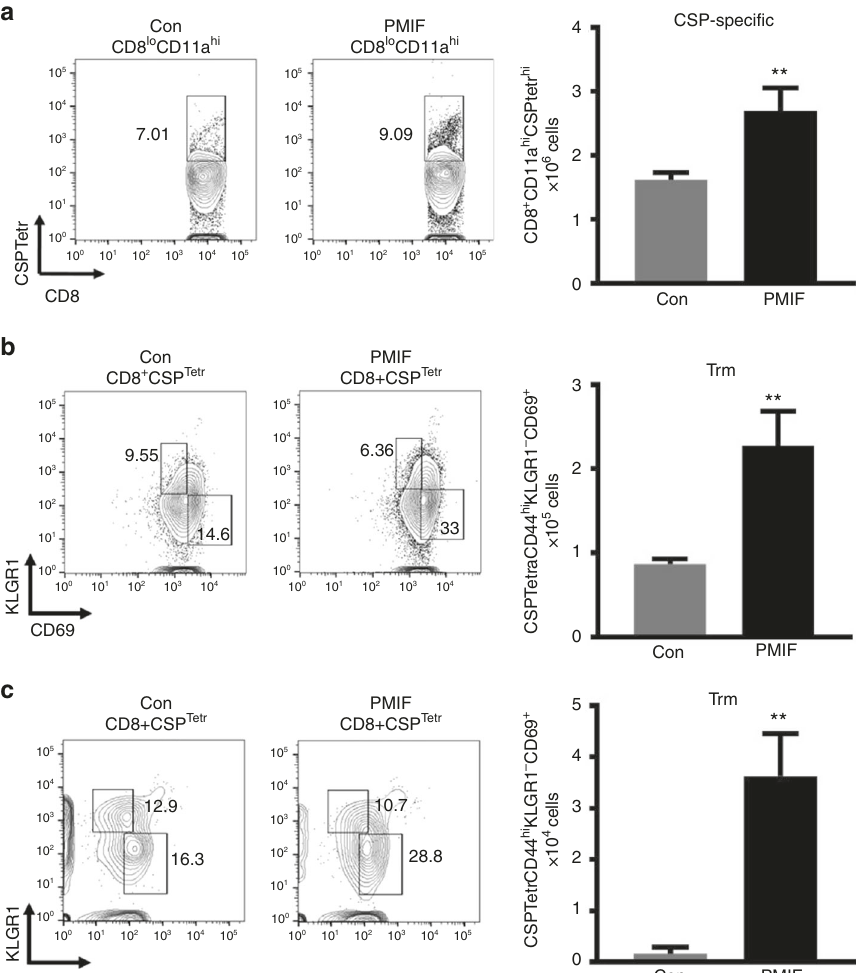
Fig. 4 PMIF neutralization enhances the development of Plasmodium liver memory CD8 T cells. BALB/cJ mice immunized with replicons encoding Con RNA or PMIF RNA were challenged with 2000 Pb AWT sporozoites by i.v. injection. On day 7 after the fi rst or second infection, liver immune cells were isolated and the percentage and total number of CD8 T cells assessed. a Representative plots and absolute numbers of CSP-speci fi c CD8 T cells (CD8 + CD11a hi CSPTetr hi ) in the livers of PMIF or Con RNA immunized mice. Results are from two separate experiments. Bars represent the mean of 6 mice ± SD; ** p = 0.0022 by Mann – Whitney test. Representative plots and absolute number of CSP-speci fi c tissue resident memory CD8 T cells (Trm: CSPTetrCD44h i KLGR1 − CD69 + ) at day 7 after the fi rst ( b ) and second ( c ) infection. Results are from two separate experiments. Bars represent the mean of 6 mice ± SD; ** p = 0.0022 by Mann – Whitney (Supplementary Figure 5a) in the pmif RNA versus the control RNA immunized group, and examination of CD8 T cell subsets revealed a corresponding increase in CSP-speci fi c Trm cells (Fig. 4b). Liver CD8 Trm cells directed against Plasmodium are long-lived 23 . To examine their development and response to a second infection, we cured immunized mice that had primary blood-stage infection by chloroquine treatment and examined CD8 Trm cell frequency 1 month later, both before and after re- infection with Pb AWT sporozoites. While the number of liver CD8 Trm cells decreased after 1 month in both the pmif and the control RNA immunized groups, there was a more than 3-fold increase in the pmif RNA immunized mice when compared with the control group (Supplementary Figure 5b). Seven days after re- infection with sporozoites, there was an expansion of this liver CD8 Trm population, with a 60% increase in CSP-speci fi c CD8 Trm cells in the pmif RNA immunized cohort when second infection is compared to the number of Trm 1 month after the fi rst infection (Fig. 4c). Moreover, there was an increase in the number of IFN γ -expressing CD8 Trm cells after the second